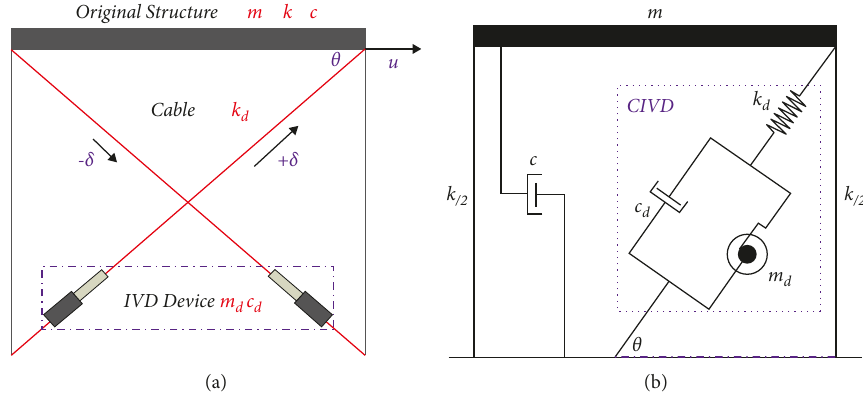
Figure 5: Layout and mechanical model of a SDOF with cable inerter viscous damper: (a) layout; (b) mechanical model.